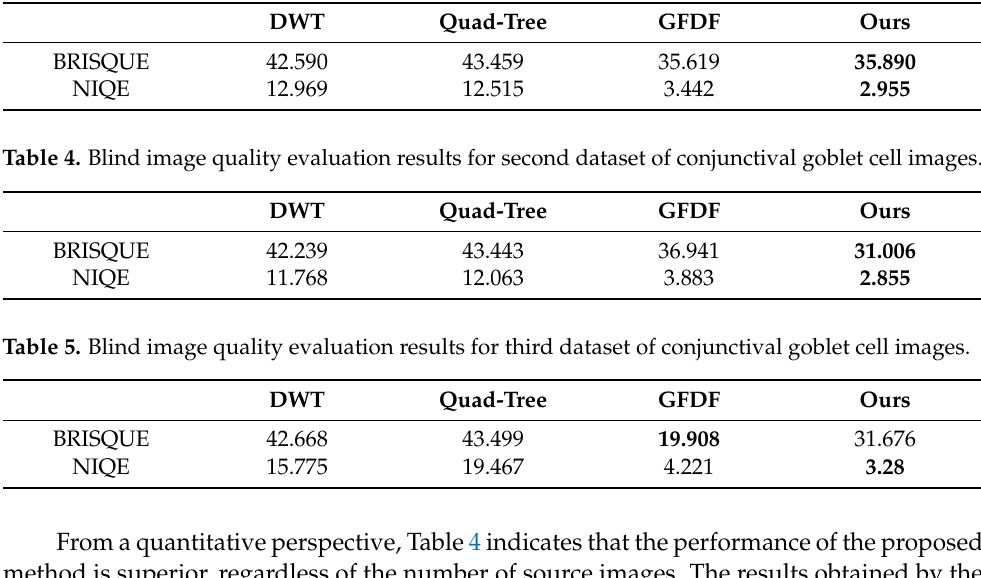
Table 3. Blind image quality evaluation results for first dataset of conjunctival goblet cell images.